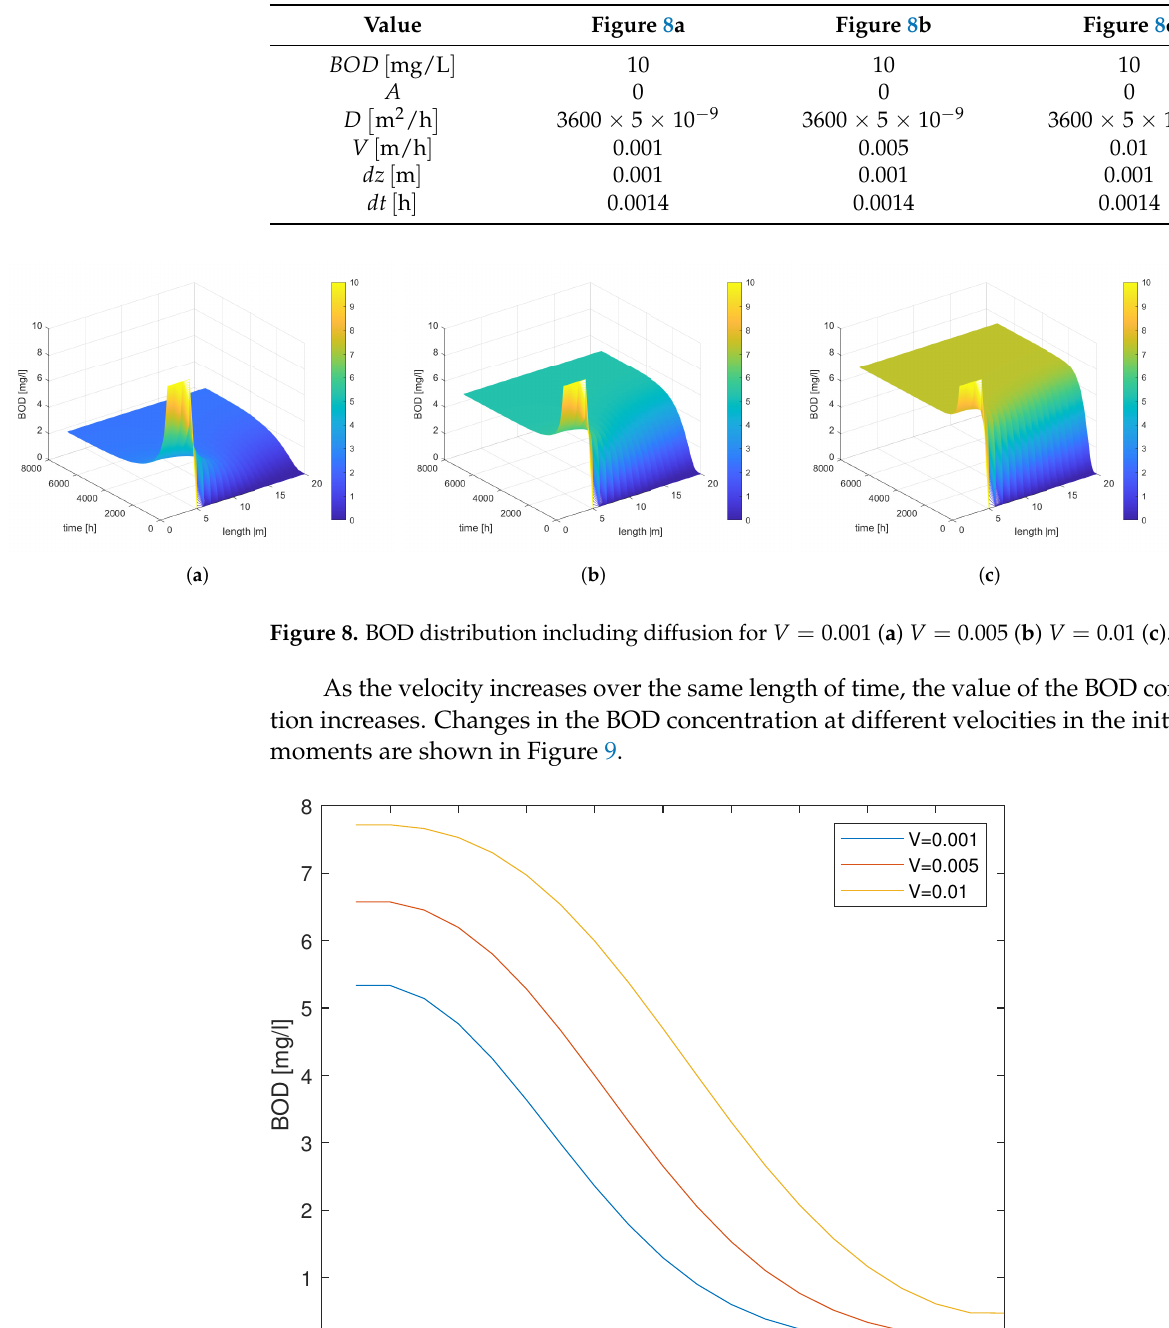
Table 4. The initial values adopted in the simulation studies for the cases shown in Figure 8.